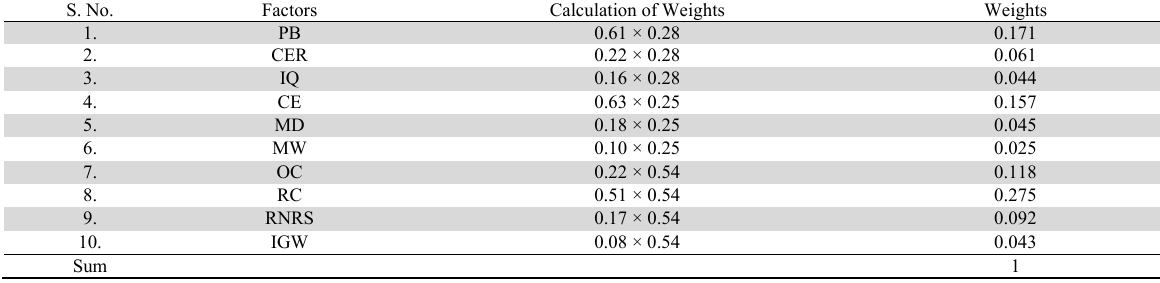
Weights of criteria